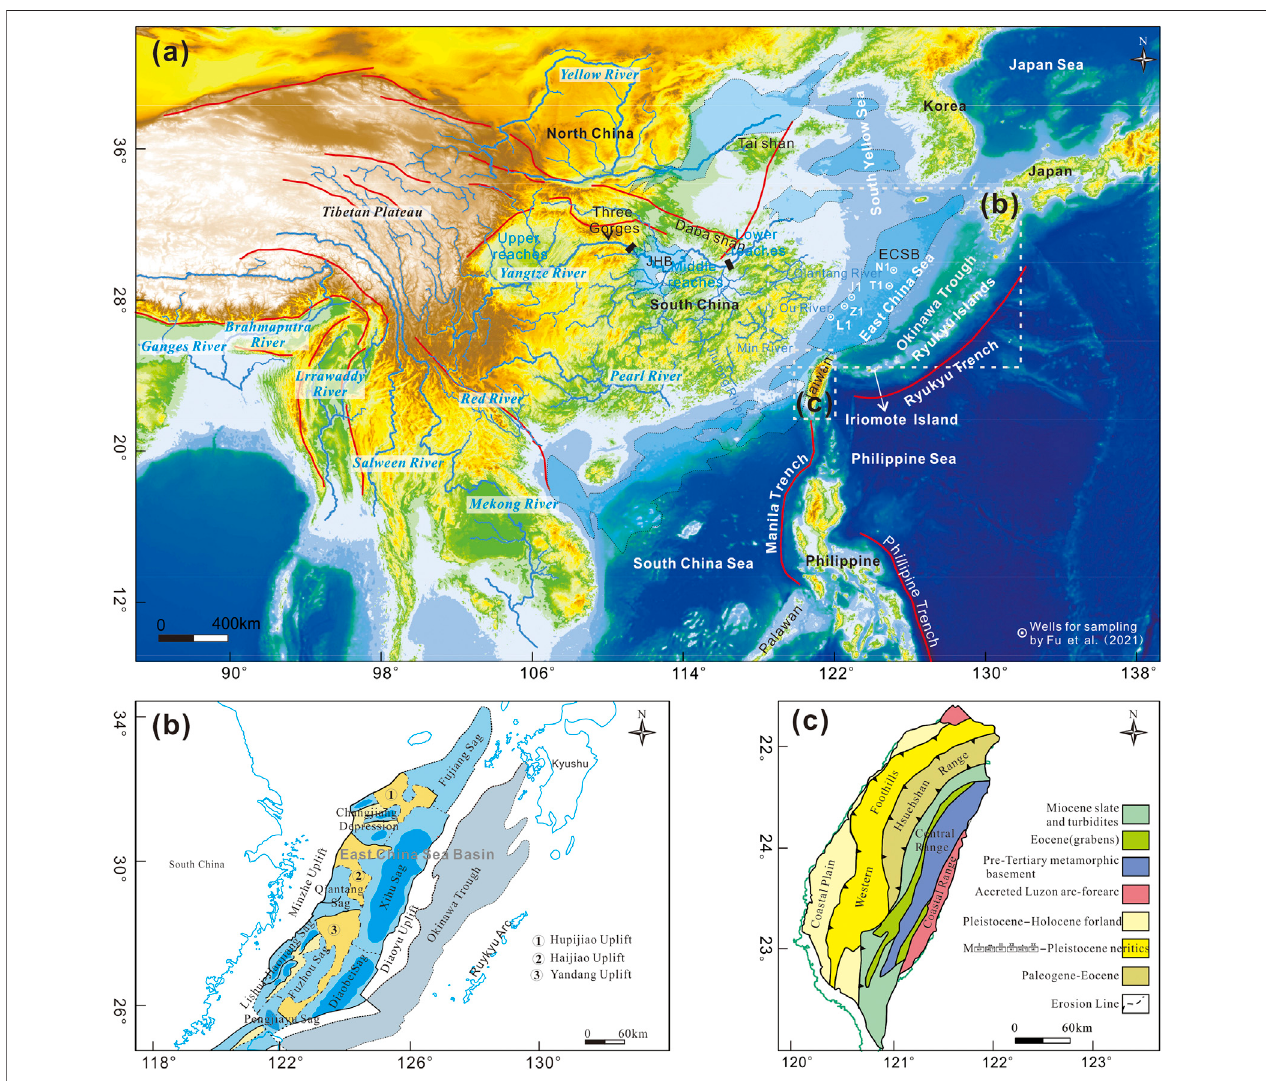
FIGURE1|(A) TopographicmapofEastAsiashowingmajorbasinsandrivers. (B) TectonicsketchoftheEastChinaSeaBasin(modi fi edfromZhuetal.,2019). (C) Tectonic framework of Taiwan (modi fi ed from Huang et al., 2012). The basins are modi fi ed from Ren et al. (2002). ECSB, East China Sea Basin; JHB, Jianghan Basin.